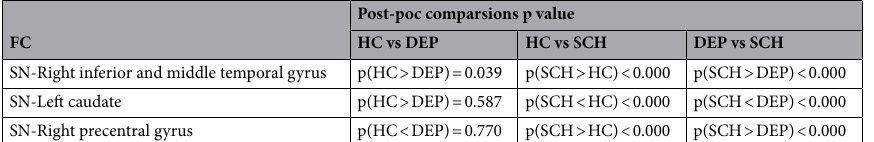
Post-poc comparsions p